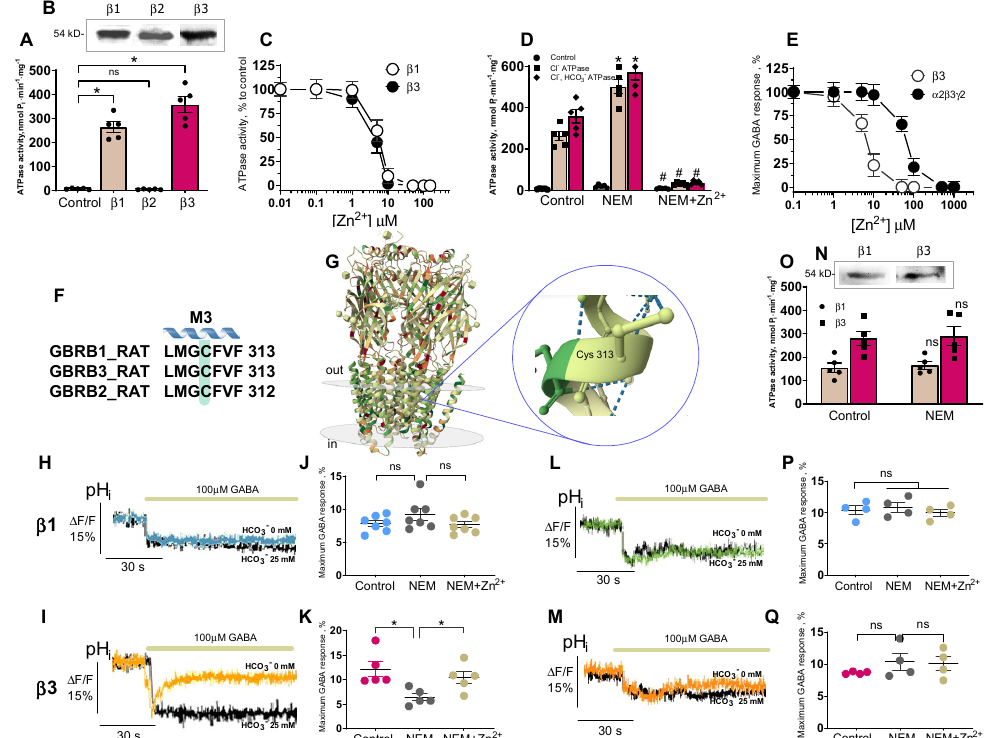
Figure 4. Zinc inhibits ATP-dependent recovery of [HCO 3 − ] i by β 3 subunit. ( A ) Bar chart showing the ATPase activity in VLPs after expression in HEK 293FT cells of GABA A R β 1, β 2 or β 3 subunit ( n = 5). ( B ) Western blot analysis binding of VLPs with antibody against GABA A R β 1, β 2 or β 3 subunit after expression of DNA GABA A R β 1, β 2 or β 3 subunit in HEK 293FT cells. ( C ) Zn 2+ concentration inhibition curves for ATPase activities in VLPs after expression in HEK 293FT cells of DNA GABA A R β 1 or β 3 subunit. ( D ) Bar chart showing the Cl − , HCO 3 − -ATPase activity in VLPs after expression in HEK 293FT cells of DNA GABA A R β 1 or β 3 subunit without or with 300 µ M NEM or 300 µ M NEM + 20 µ M Zn 2+ in an experimental medium: Student’s unpaired t -test, p < 0.0008 ( n = 5), p < 0.0073 ( n = 5) and p < 0.0001 ( n = 5), p < 0.0001 ( n = 5). ( E ) Zn 2+ concentration inhibition curve recording for average maximum the GABA response recording in HEK 293FT cells expressing GABA A R β 3 or α 2 β 3 γ 2 subunits. ( F ) The amino acid sequences of β 1, β 2 and β 3 subunits that contained the cysteine residues (Protein Bank). ( G ) Architecture of GABA A R- β 3 cryst (five subunits from five are shown) and cysteine residue (C313) in M3 domain of β 3 subunit (Protein Data Bank). ( H , I ) Corresponding BCECF fluorescence changes for HEK 293FT cells expressing GABA A R β 1 or β 3 subunit recorded in response to 100 µ M GABA application without or with 25 mM HCO 3 − in an experimental medium ( n = 5). ( J , K ) Bar chart showing average maximum GABA response in HEK 293FT cells expressing GABA A R β 1 or β 3 subunit in the presence of 25 mM HCO 3 − in an experimental medium, before and after 300 µ M NEM or 300 µ M NEM + 20 µ M Zn 2+ application: Student’s unpaired t -test, p = 0.1894 ( n = 7) and p = 0.1453 ( n = 7). ( L , M ) Corresponding BCECF fluorescence changes for HEK 293FT cells expressing GABA A R β 1 or β 3 subunit recorded in response to 100 µ M GABA application without or with 25 mM HCO 3 − in an experimental medium ( n = 5). ( N ) Western blot analysis binding of VLPs with antibody against GABA A R β 1 or β 3 subunit after expression of mutant (C313A) GABA A R β 1 or β 3 subunit in HEK 293FT cells. ( O ) Bar chart showing ATPase activity in VLPs after expression in HEK 293FT cells of mutant (C313A) DNA GABA A R β 1 or β 3 subunit before and after 300 µ M NEM application: Student’s unpaired t -test, p = 0.7121 ( n = 5) and p = 0.8232 ( n = 5). ( P , Q ) Bar chart showing average maximum GABA response in HEK 293FT cells expressing mutant GABAAR β 1 or β 3 subunit in the presence of 25 mM HCO 3 − in an experimental medium, before and after 300 µ M NEM or 300 µ M NEM + 20 µ M Zn 2+ application: Student’s unpaired t -test, p = 0.2826 ( n = 4) and p = 0.6583 ( n = 4) and p = 0.2353 ( n = 4) and p = 0.8668 ( n = 4). Data are presented as ± mean SEM. * p < 0.05, ns, not significant; # p < 0.05, is significant between NEM and NEM + Zn 2+ .